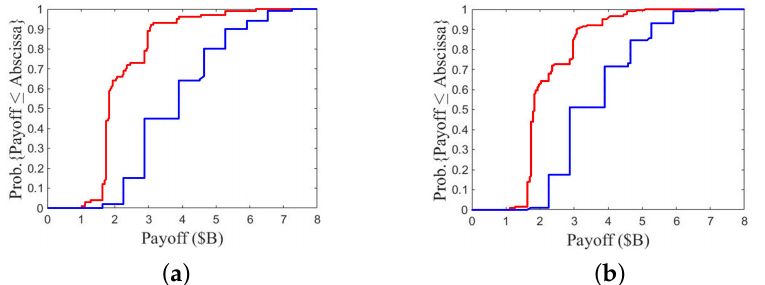
Figure 3. (A2/B3) Cumulative distribution of payoff with one P 2 SO run, ( a ) over 100 games, ( b ) over 200 games; ———: fleet A, ———: fleet